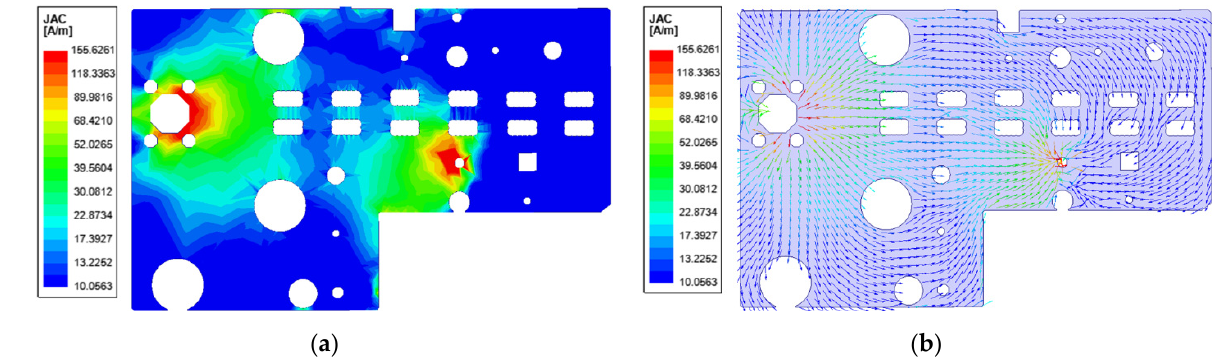
Figure 9. Q3D simulation results at top layer. ( a ) Current density. ( b ) Current flow.